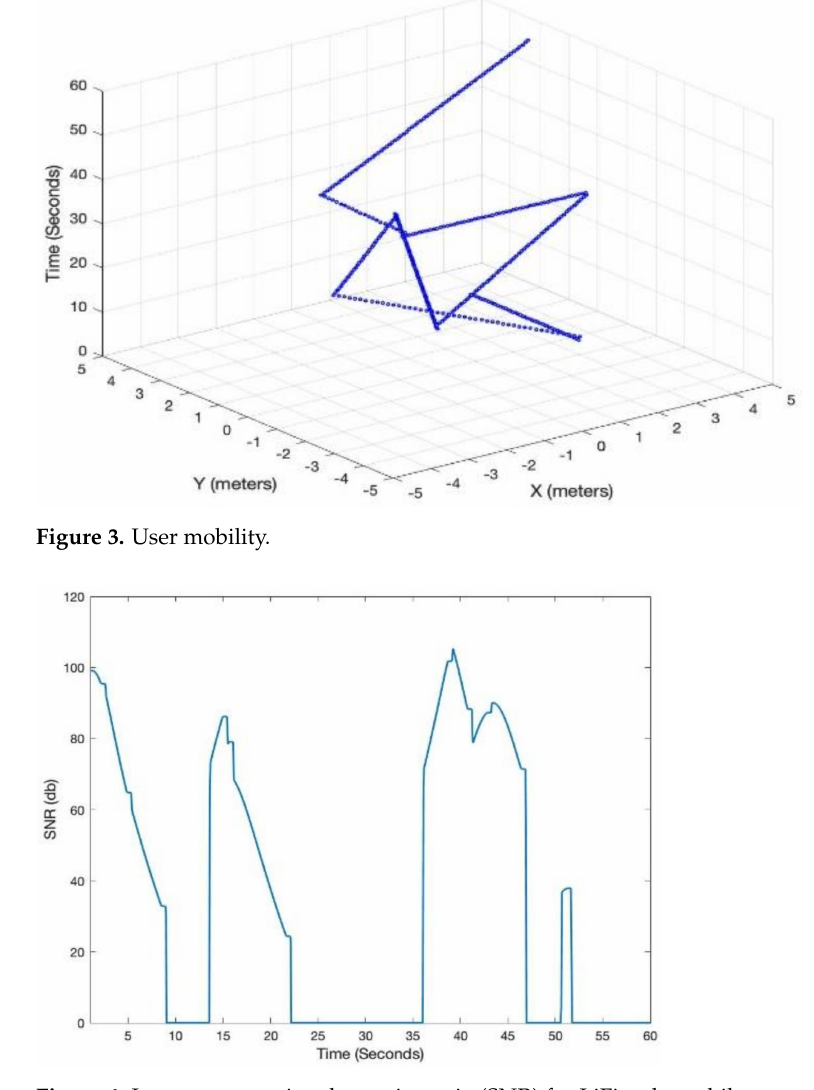
Figure 4. Instantaneous signal-to-noise ratio (SNR) for LiFi-only mobile